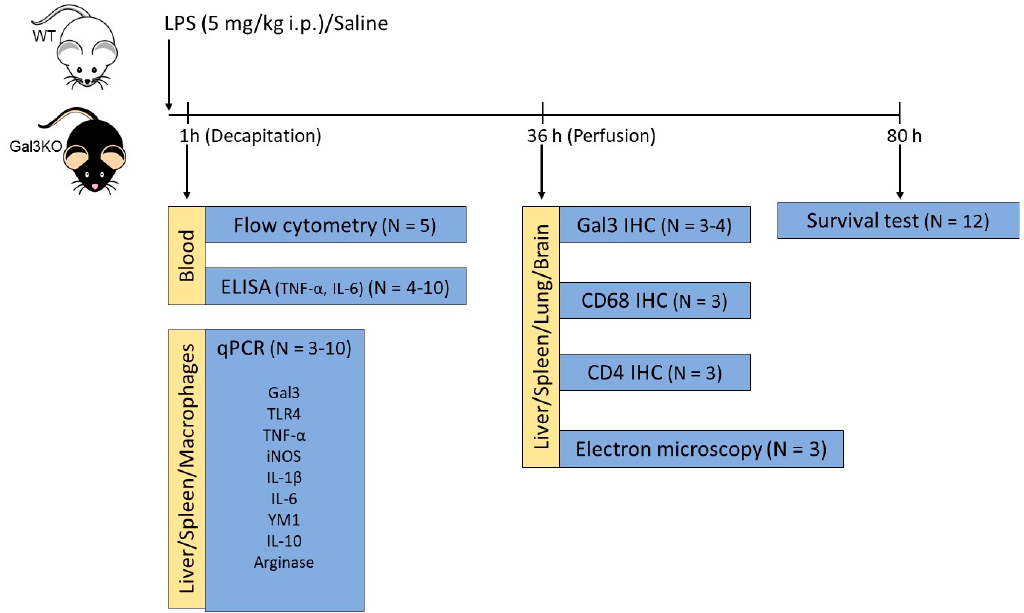
Figure 14. Timeline of the treatments with LPS in animals, and points at which the different param- eters have been measured. WT and Gal3KO animals were injected with either LPS or saline and sacrificed at different time points depending on the technique assayed. The number of animals used in each experiment isalso indicated.